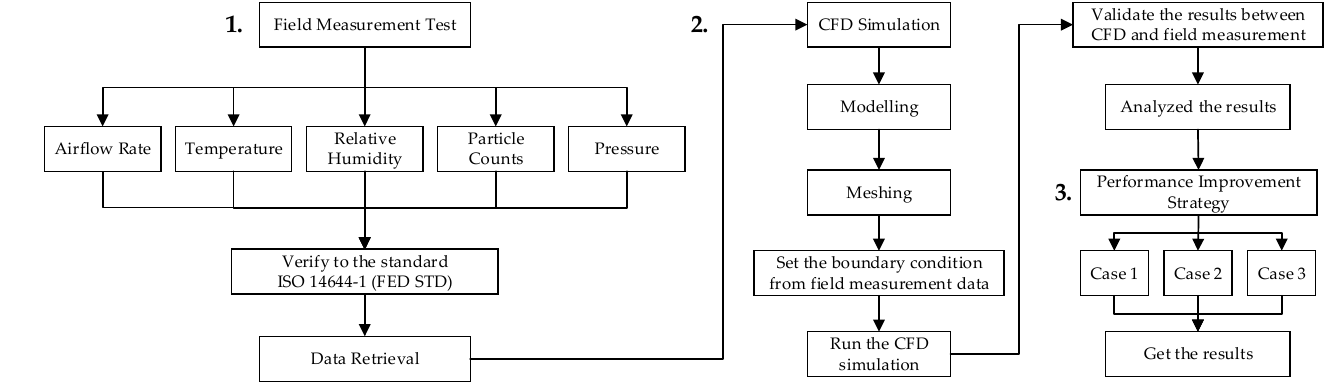
Figure 2. The proposed methodology framework.